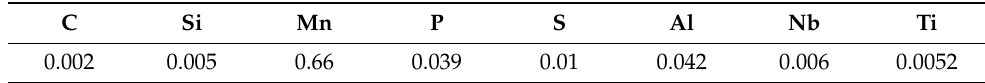
Table 2. Chemical composition of the steel grade